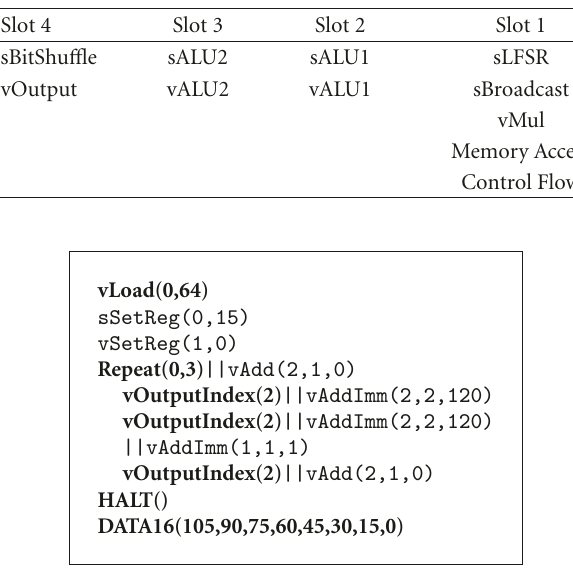
Algorithm 1: iVAG assembly code for a 24 × 15 matrix interleaving